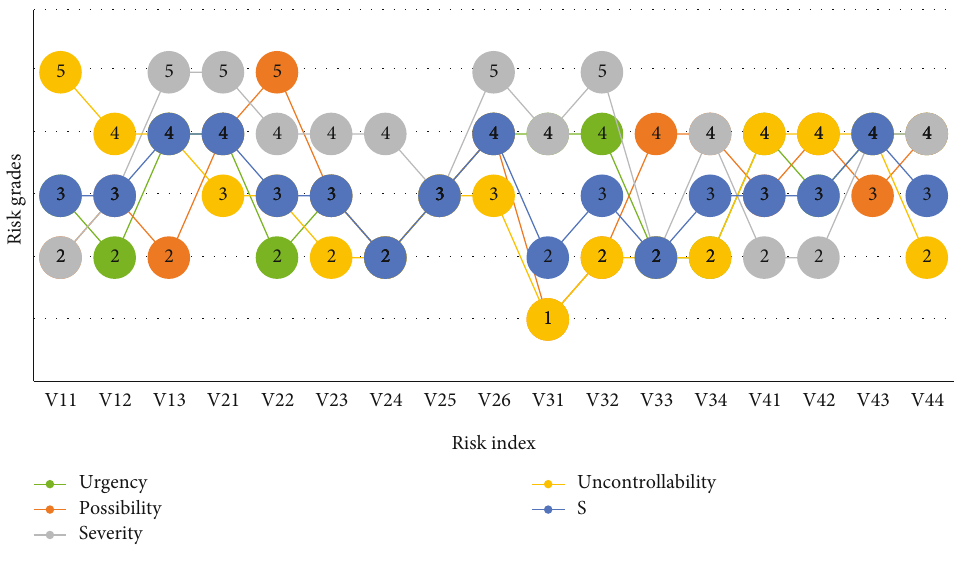
Figure 7: Risk grades in di ff erent dimensions.